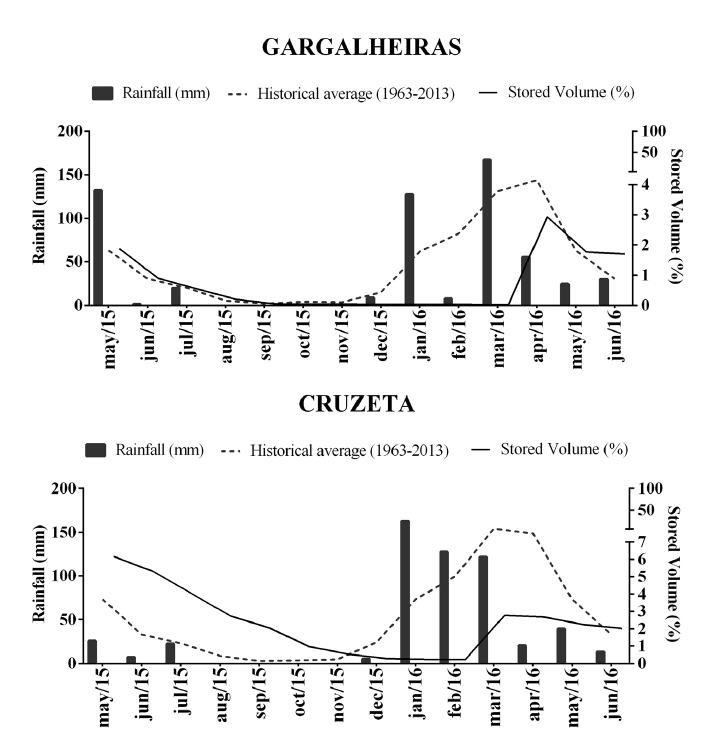
Figure 2. Monthly rainfall, historical average rainfall and stored volume of the Gargalheiras and Cruzeta reservoirs, from May/2015 to June/2016.